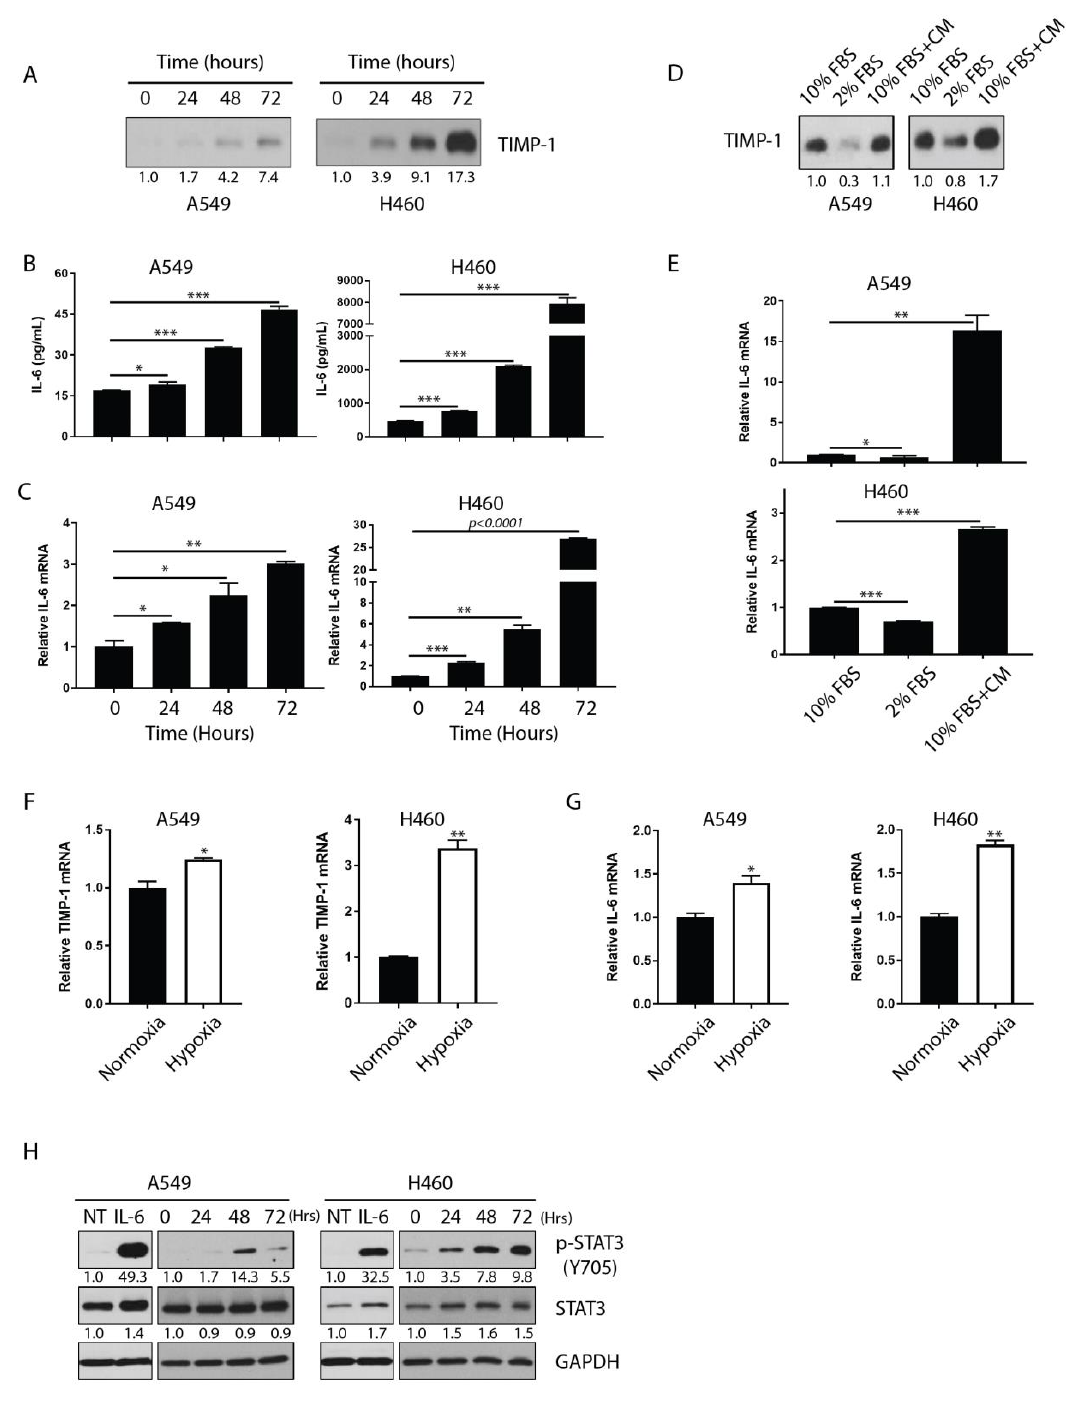
Figure 2. IL-6 expression is closely correlated with TIMP-1 production. ( A ) NSCLC cells (A549 and H460) were cultured in complete medium for three consecutive days. Supernatants were collected at 0, 24, 48, and 72 h. Cell attachment time was defined as the 0 h time point. Equal volumes of supernatants were loaded for human TIMP-1-specific immunoblotting analysis under reduced conditions. ( B ) Supernatants were used to measure IL-6 production at the same time-points by ELISA. ( C ) IL-6 mRNA transcripts were also measured in cells at these time-points by real-time RT-PCR. ( D ) A549 and H460 cells were cultured in normal complete medium (10% FBS), FBS-reduced medium (2% FBS), and conditioned culture medium (1:1 mixture of 10% FBS medium and conditioned medium, 10% FBS + CM) for three days. Equal volumes of supernatants were loaded for human